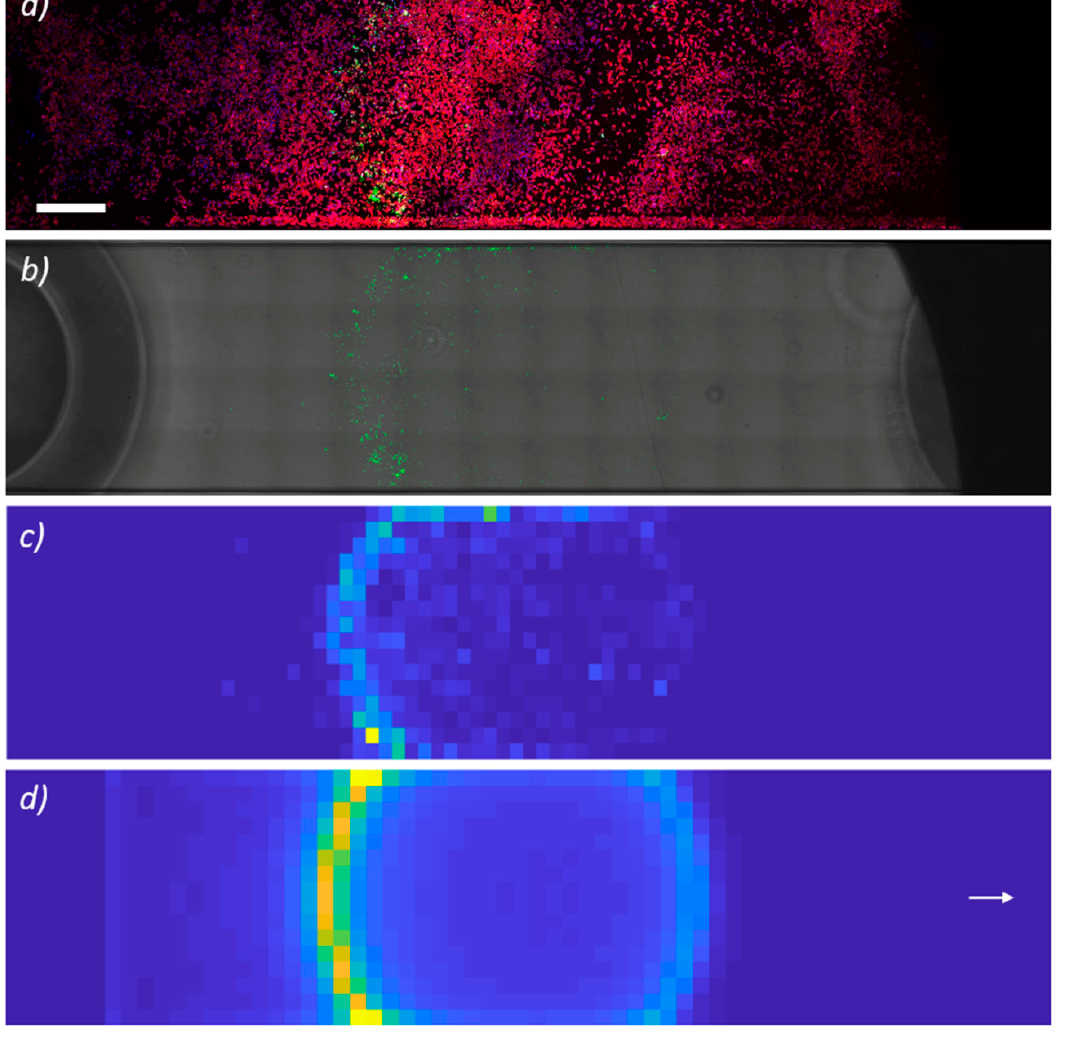
Figure 6. Confocal microscopy of the bottom side of the microchannel after human umbilical vein endothelial cells (HUVECs) staining (f-actin in red, nuclei in blue) ( a ). Fluorescent-labeled MagLipo (in green) are visible in a round-shaped area confirming selective magnetic cell internalization in correspondence of the edge of the external magnet. Distribution of fluorescence-labeled Mag-Lipo (in green), as attracted by the external magnetic field and internalized by HUVECs seeded at the bottom of the microchannel (bright field merged to MagLipo fluorescent signal) ( b ). ( c ) Density contour plot of the captured MagLipo, as obtained by fluorescence-based experimental recordings ( c ). Density contour plot of the captured MagLipo, as predicted by the numerical model; the arrow indicates flow direction ( d ). Flow velocity was set at 3.11 mL/min. Scale bar is 1 mm.